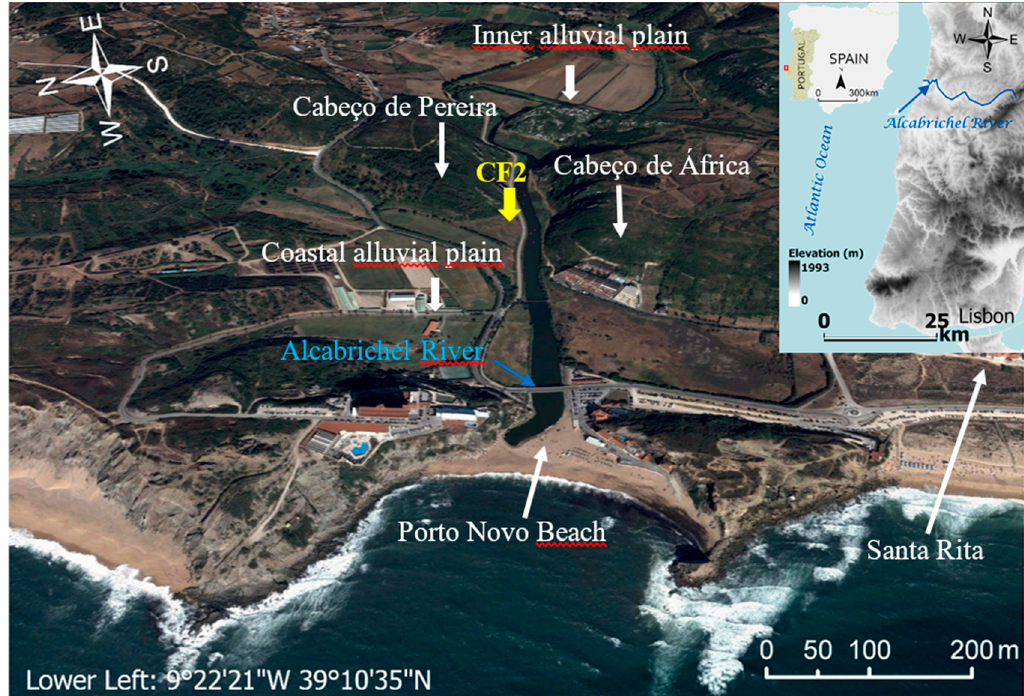
Figure 1. Study area and location of the core CF2 on the Portuguese western coast, near the mouth of the Alcabrichel River. Upper right image is derived from Aster Digital Elevation Model for Portugal, 30 m spatial resolution (WGS 84) and elevations referenced to mean sea-level (MSL): Cascais vertical datum.